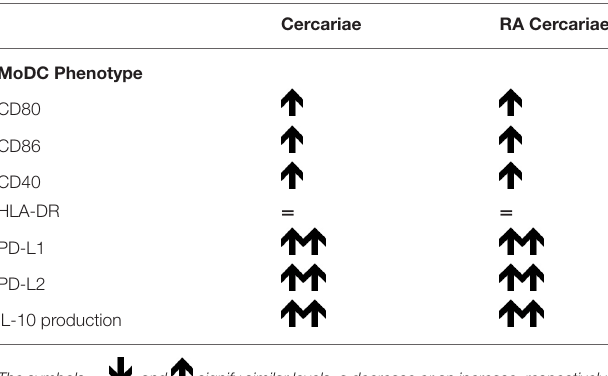
TABLE 3 | Immune phenotype of (RA) cercariae stimulated Monocyte derived